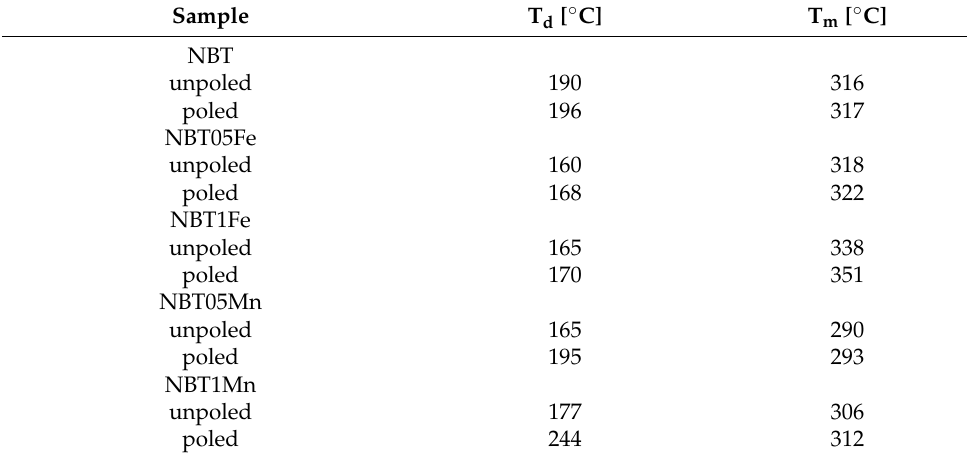
Table 2. T d and T m of investigated